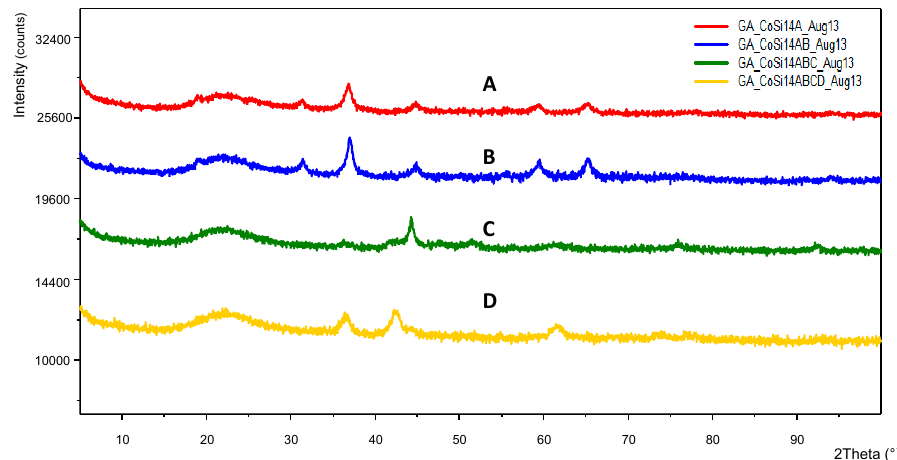
Figure 13. XRD patterns of Co/Si = 1/4 Mw at various stages of processing ( A , B , C ) and after being used for Fischer-Tropsch synthesis ( D ).